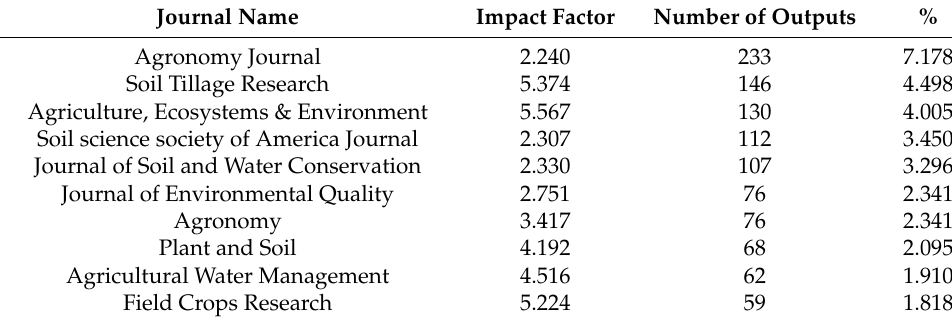
Table 2. Top 10 journals with peer ‐ reviewed articles related to CC.